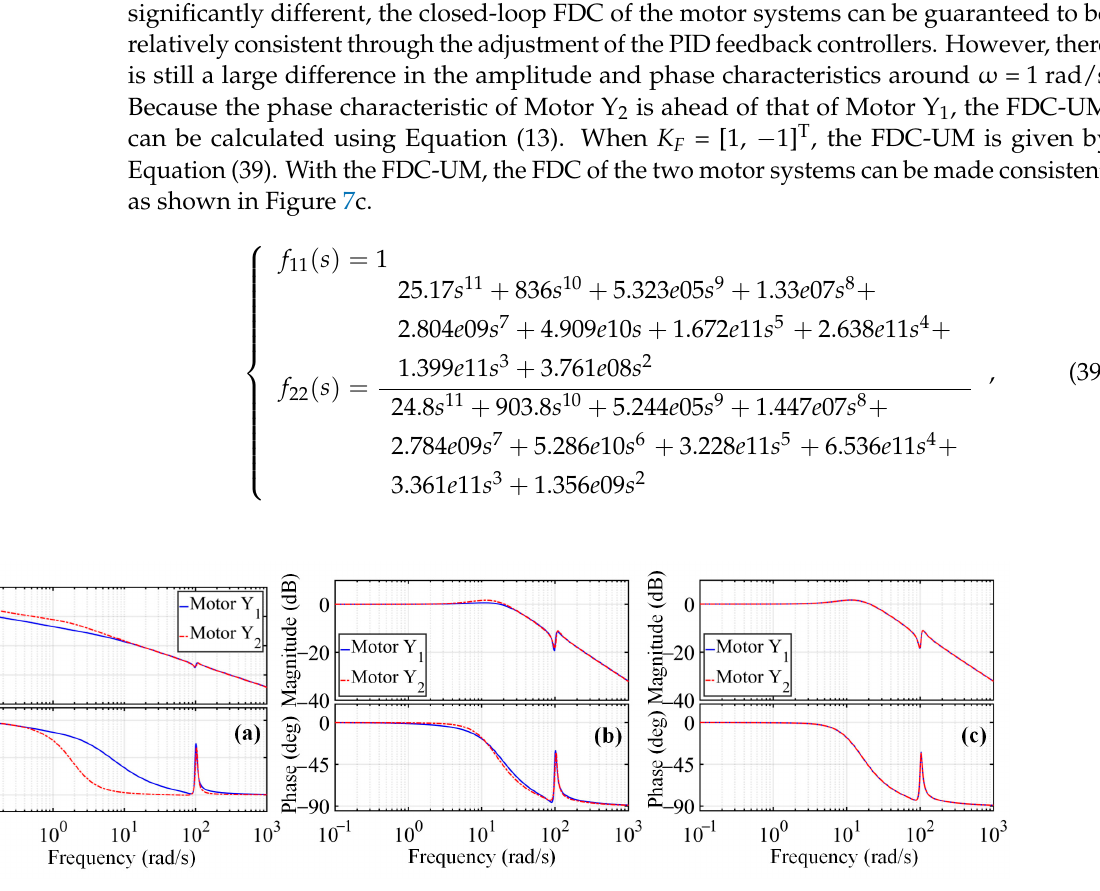
Figure 8. Diagram of the friction compensation voltage.